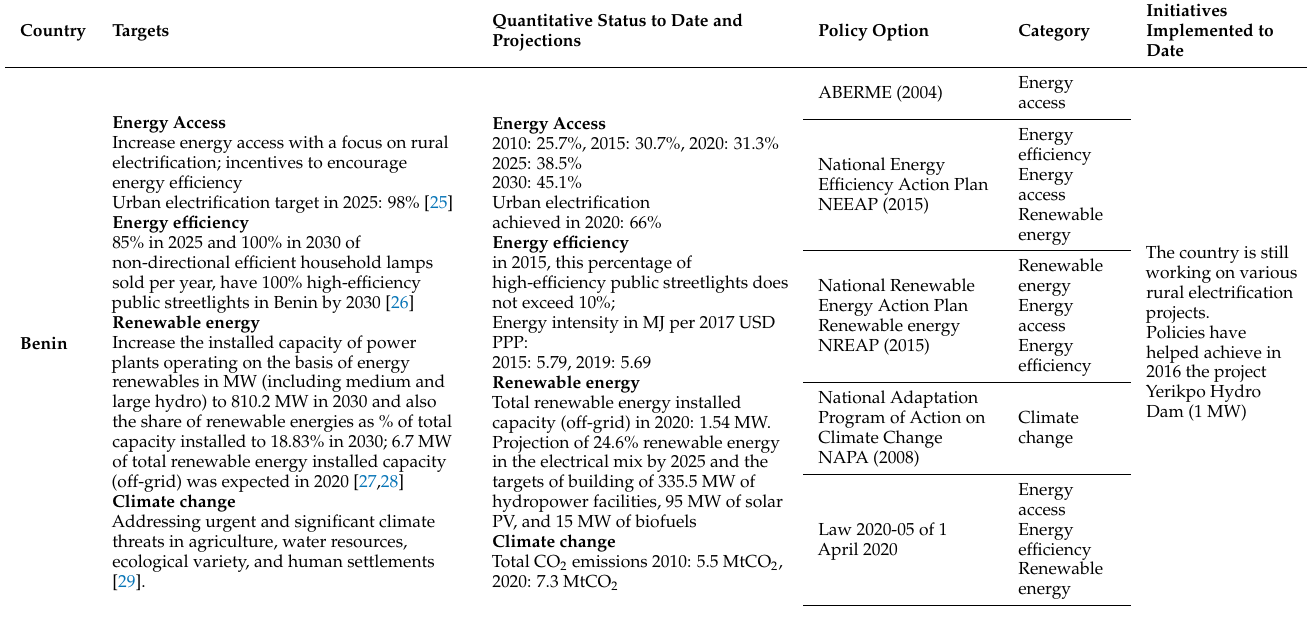
Benin, Table 2: Burkina Faso, Table 3: Cabo Verde, Table 4: C ô te d’Ivoire, Table 5: Gambia, Table 6: Ghana, Table 7: Guinea, Table 8: Guinea Bissau, Table 9: Liberia, Table 10: Mali, Table 11: Niger, Table 12: Nigeria, Table 13: Senegal, Table 14: Sierra Leone, Table 15: Togo) show the list of selected policies for each country, with a short description of targets, quantitative status and initiatives implemented to date. Table 1. Benin (data from